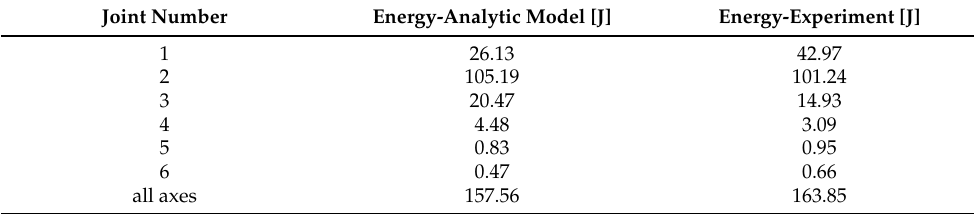
Table 6. Comparison of the specific energy modelled and measured for each